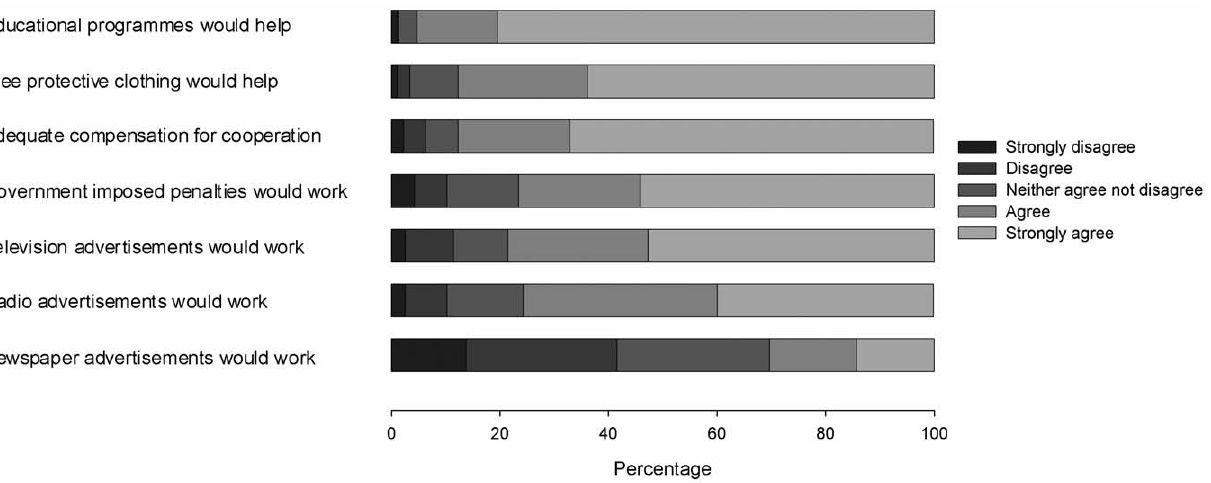
Figure 1. Cues to action, n=349. The most popular interventions for facilitating the adoption of protective behaviours and practices were: educational programmes, supply of free protective clothing, adequate compensation for cooperating with test and slaughter campaigns, government imposed penalties, and television and radio advertisements for dissemination of positive health seeking behaviour re-enforcing messages. More than 75% of respondents either strongly agreed or agreed to these suggested interventions. In contrast, just about 30% agreed or strongly agreed to newspaper adverts. doi:10.1371/journal.pone.0056091.g001 PLOS ONE |